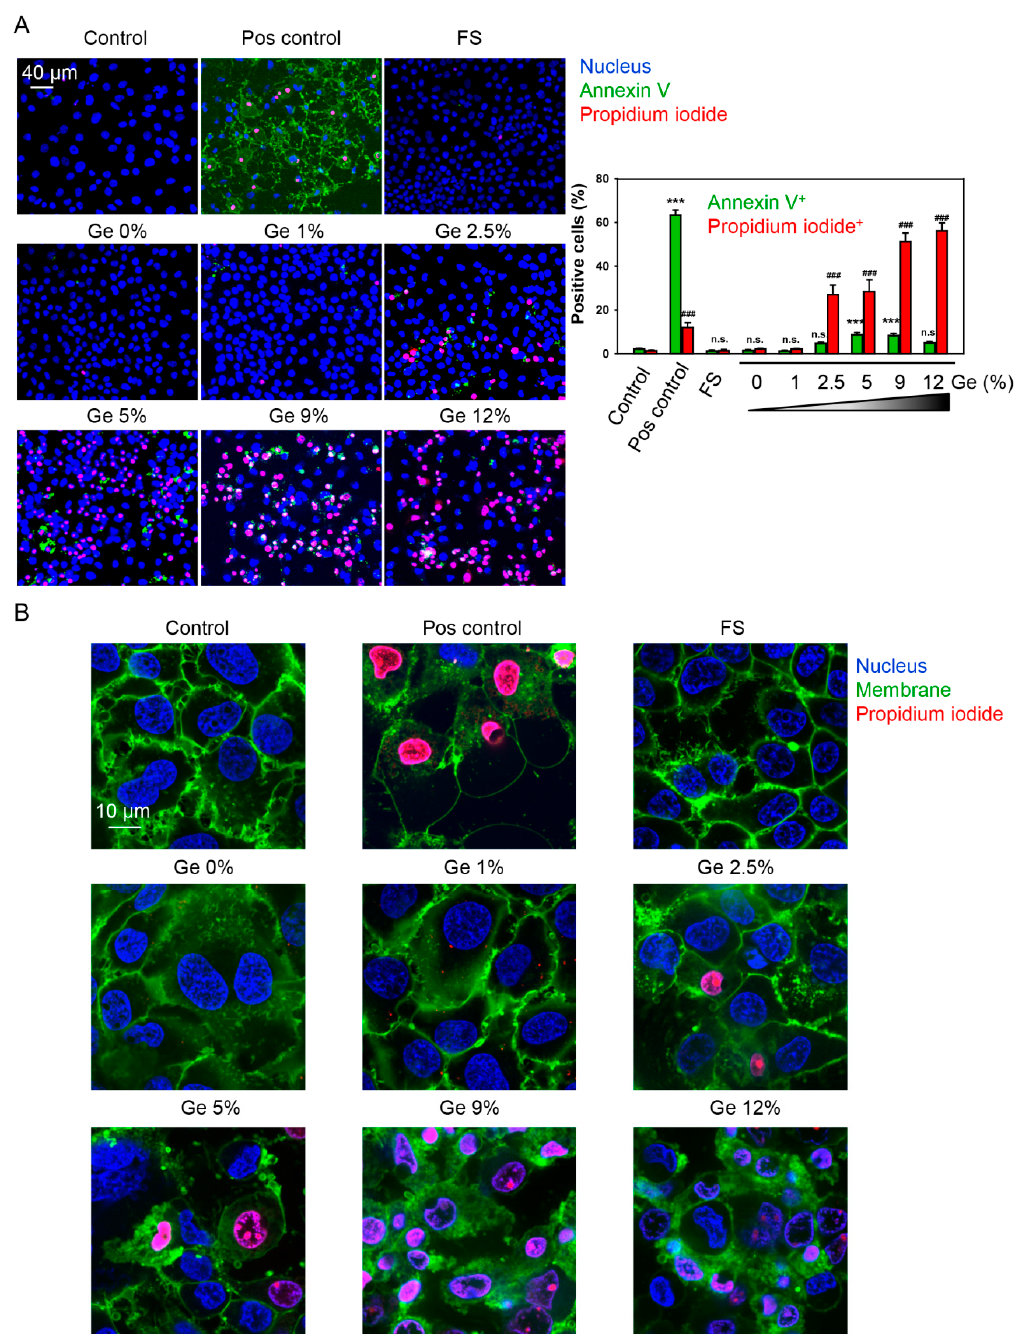
Figure 5. ( A ) Analysis of apoptotic cell death. Huh7 were grown on different Ge substrates for 5 days and labeled with annexin V—green dye, propidium iodide—red dye, Hoechst 33,342 nuclear stain—blue. The merging of blue and red gives magenta color. Labeled cells were then imaged using spinning disk confocal microscopy. ImageJ software (NIH) was used for image processing and quantification. One-way ANOVA with Newman–Keuls multiple comparison test was used. Data are expressed as means ± SEM (n = 3), *** p < 0.001. As positive control, 20 µM staurosporine for 2 h was used. ( B ) Huh7 were grown on different Ge substrates for 5 days and labeled with propidium iodide—red dye, Hoechst 33,342 nuclear stain—blue. The merging of blue and red gives magenta color. Cell membranes were labeled with CellMask™ Green (green). Labeled cells were then imaged using high-resolution spinning disk confocal microscopy. ImageJ software (NIH) was used for image processing. As a positive control, cells were treated with 20% ethanol for 60 min.